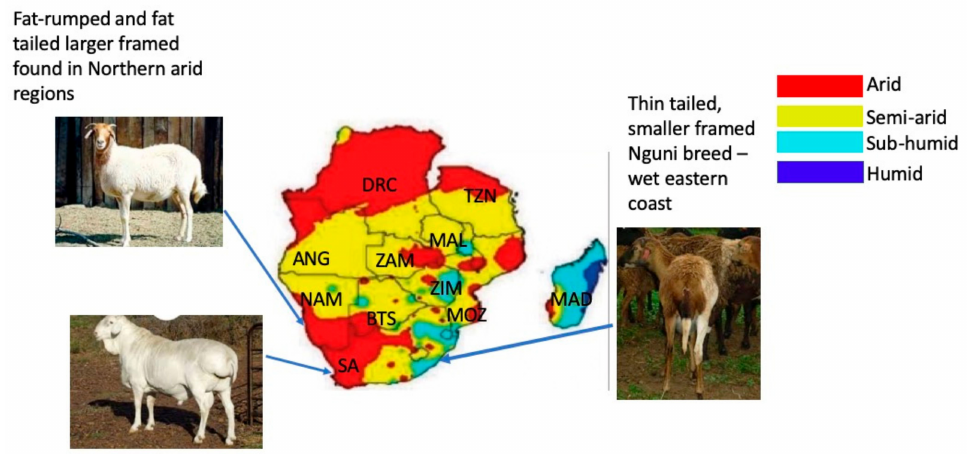
Figure 1. Map depicting the climatic regions of the Southern Africa Development Community (SADC)region as well as the presence of ovine genetic resources according to typical distribution. *ANG -Angola; BTS—Botswana; DRC—Democratic Republic of Congo; MAD—Madagascar; MALMalawi; MOZ—Mozambique; NAM—Namibia; SA—South Africa; TZN—Tanzania;